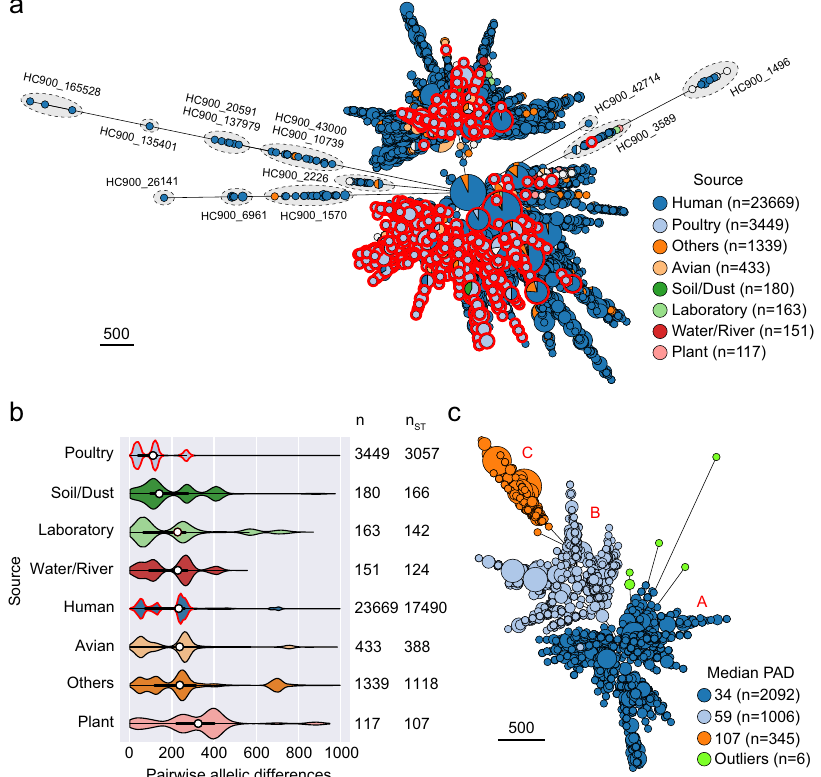
Fig. 3 Global population structure and genomic diversity of Salmonella Enteritidis. a Minimum spanning tree of 30,015 Salmonella Enteritidis isolates of 22,775 cgMLST sequence types (cgSTs) in EnteroBase. Each node represents a distinct cgST or cgSTs differed by only missing data. The size of each node indicates the number of isolates within that node. Isolates are color coded by EnteroBase-de fi ned sources. Only sources with at least 100 cgSTs are shown. Nodes containing poultry isolates are highlighted by red border. The majority of isolates belong to the HC900_12 cluster de fi ned by EnteroBase. Clusters not belonging to HC900_12 are highlighted by dashed ovals. The scale bar indicates 500 cgMLST alleles. An interactive version of the tree is available at https://enterobase.warwick.ac.uk/ms_tree/51520. b Comparison of intra-source pairwise allelic differences (PADs) based on individual STs. Violin plots show probability densities of PADs. Each boxplot within a violin plot summarizes the distribution of PADs of all isolates in a source. White circles indicate the median PAD values. Thick black bars represent the interquartile ranges. Thin black lines indicate the ranges between maximum and minimum values. Only sources with numbers of isolates ( n ) and cgSTs ( n ST ) ≥ 100 are shown. “ Others ” includes isolates without source information or not belonging to any speci fi c source de fi ned in EnteroBase. PADs larger than 1,000 are considered outliers and not included. The peaks of kernel density estimate of the PAD distributions of poultry and human isolates are outlined in red. c Minimum spanning tree of 3,449 Salmonella Enteritidis poultry isolates of 3,057 cgSTs in EnteroBase. Three sub-populations of poultry isolates (A, B, and C) and their individual median PADs are shown. Six outlier isolates (green) belong to four different HC200 clusters including HC200_13575 ( n = 3), HC200_12160 ( n = 1), HC200_1522 ( n = 1). The rest of isolates in A, B, and C belong to the same HC200 cluster, HC200_12. The scale bar indicates 500 cgMLST alleles. An interactive version is available at https://enterobase.warwick.ac.uk/